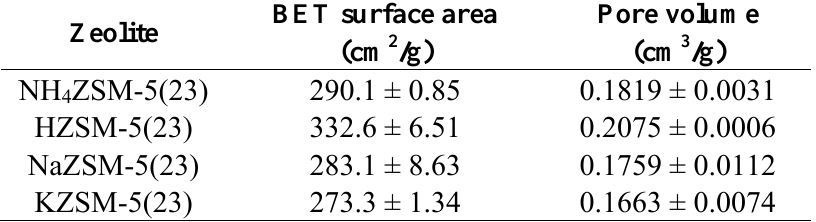
Table 2. Surface areas and pore volumes of the